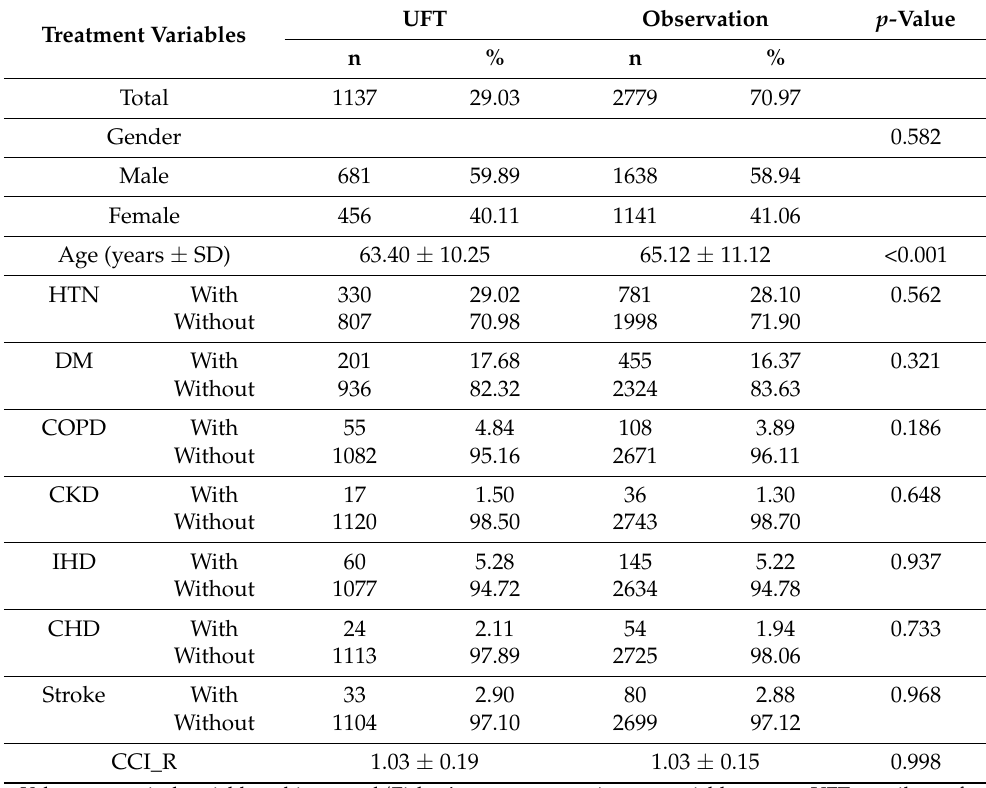
Table 1. Characteristics of study in the baseline. Treatment Variables